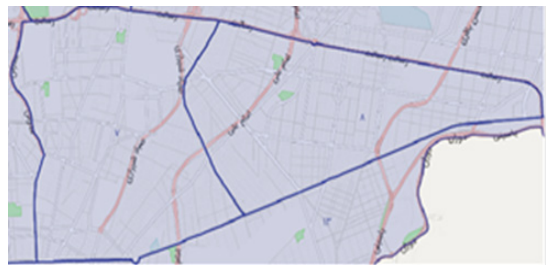
Figure 1: Tehran Municipality 7 and 8